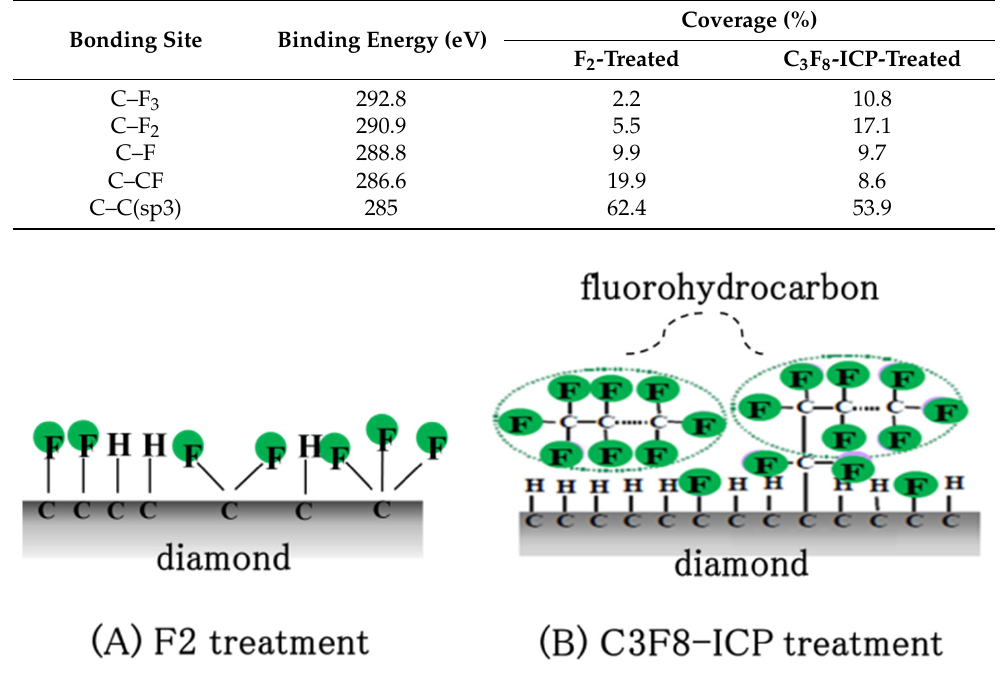
Figure 4. Schematic diagram of the C–F diamond surface: ( A ) a C–F diamond surface with a small amount of fluorohydrocarbon fabricated via fluorine gas treatment (F 2 treatment) and ( B ) a C–F diamond surface with fluorohydrocarbon fabricated via perfluoropropane–ICP (C 3 F 8 -ICP) treat- ment. Table 1. Quantification of the bonding state of fluorine functional groups on the C–F diamond sur- face.